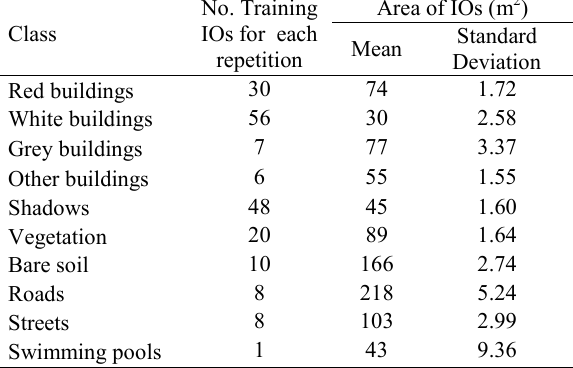
Table 2. Characteristics of four IOs repetitions extracted for the classifier training.